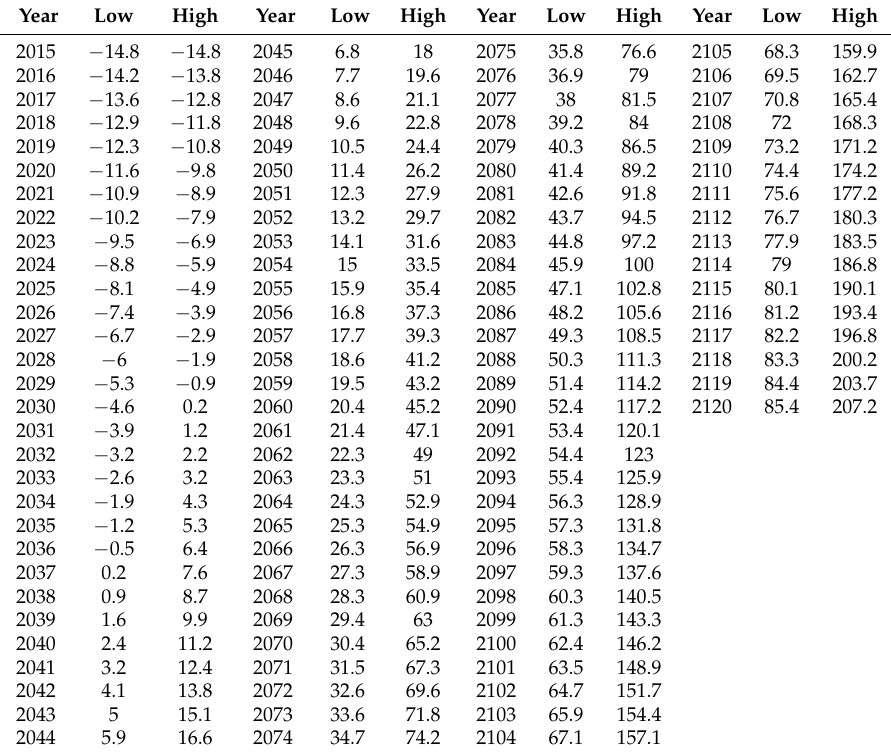
Table A2. Sea level rise in cm NAVD88 from Kopp et al.